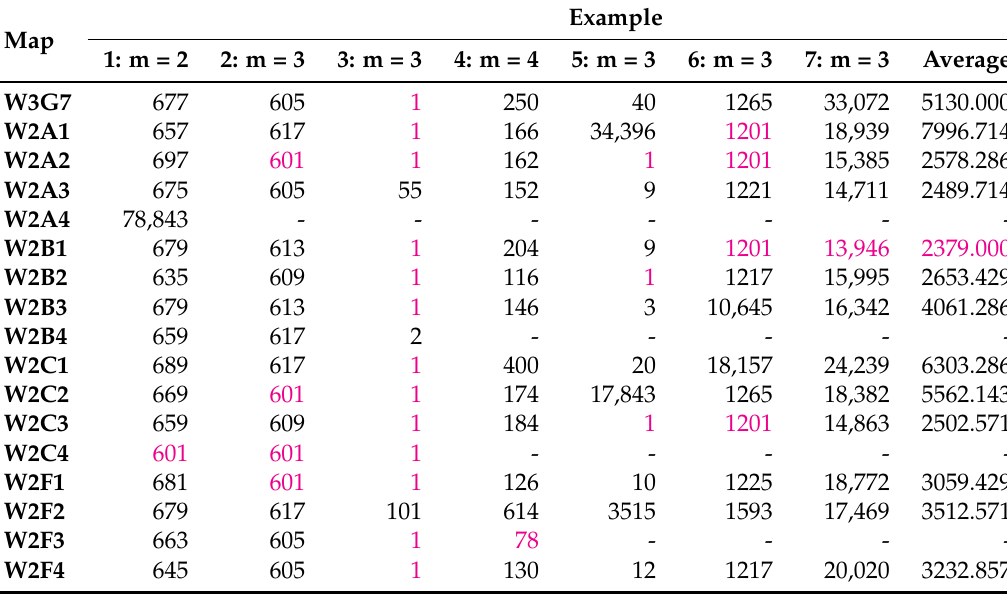
Table 7. Number of points requiring 40 iterations for each example